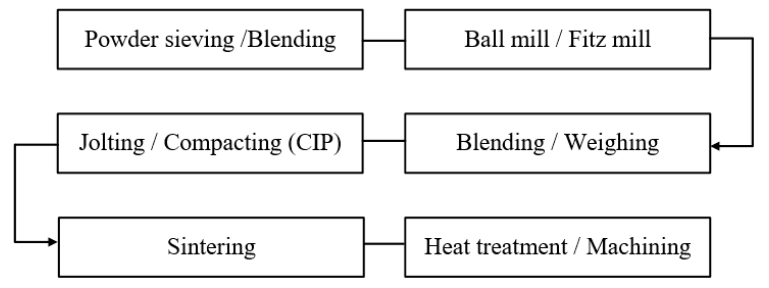
Figure 1. Process sequence for the THA tube fabrication.